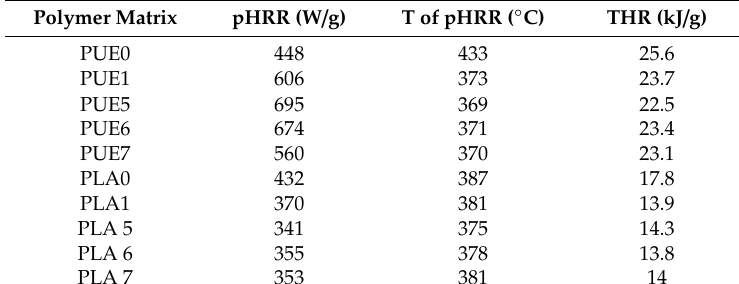
Table 6. PCFC results for PUE and PLA / APP composites.